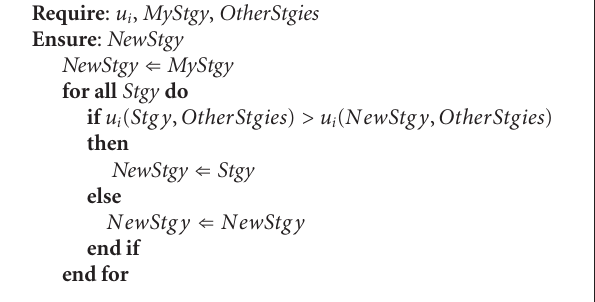
Algorithm 1: UnilaterallyMax(player- i ).